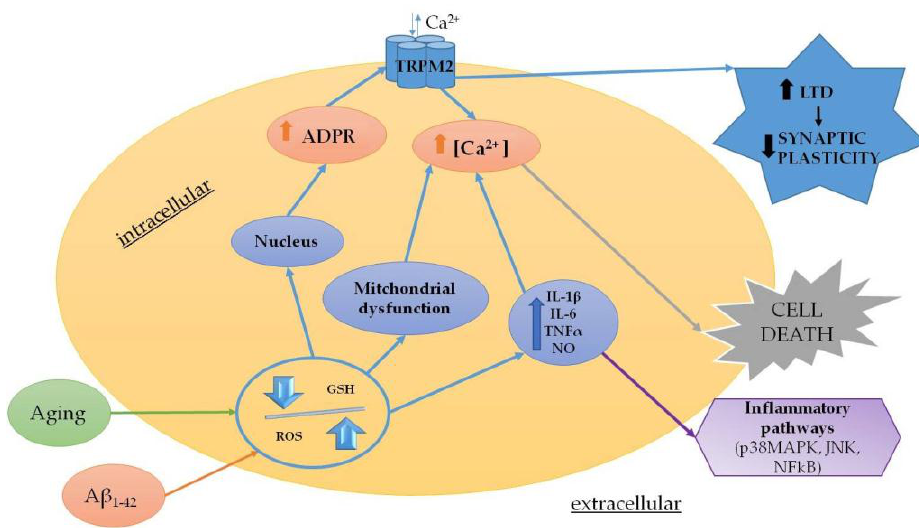
Figure 2. Summary of the main mechanisms modulated by TRPM2 in chronic neurodegenerative diseases.